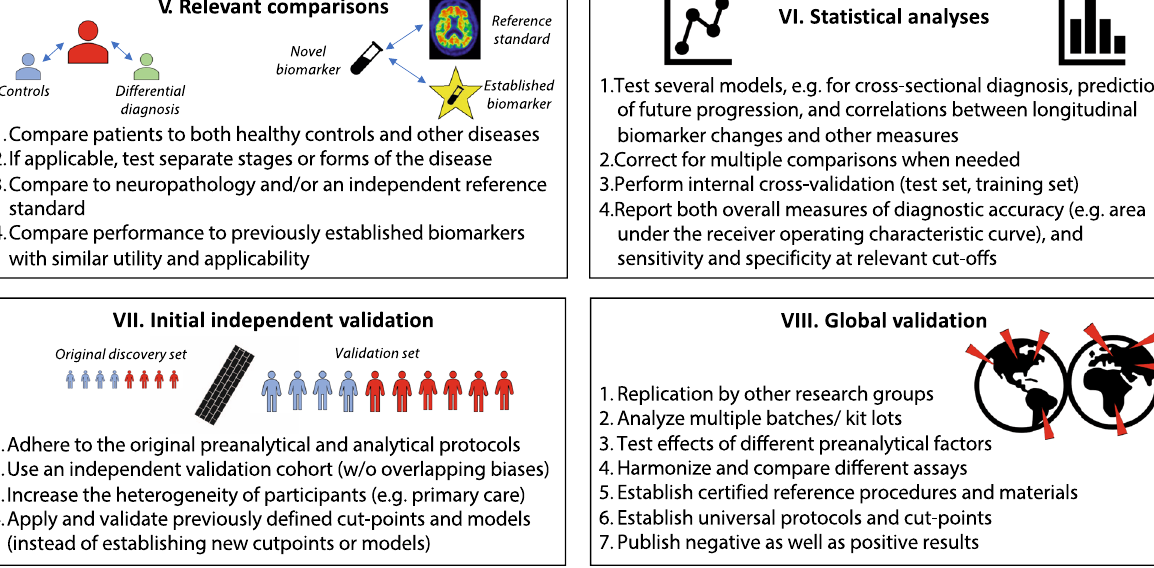
Fig. 2 Finding reproducible biomarkers, from relevant comparisons to validation. A fl owchart highlighting key points described in the review, with examples of key factors that in fl uence reproducibility from including relevant comparisons to global